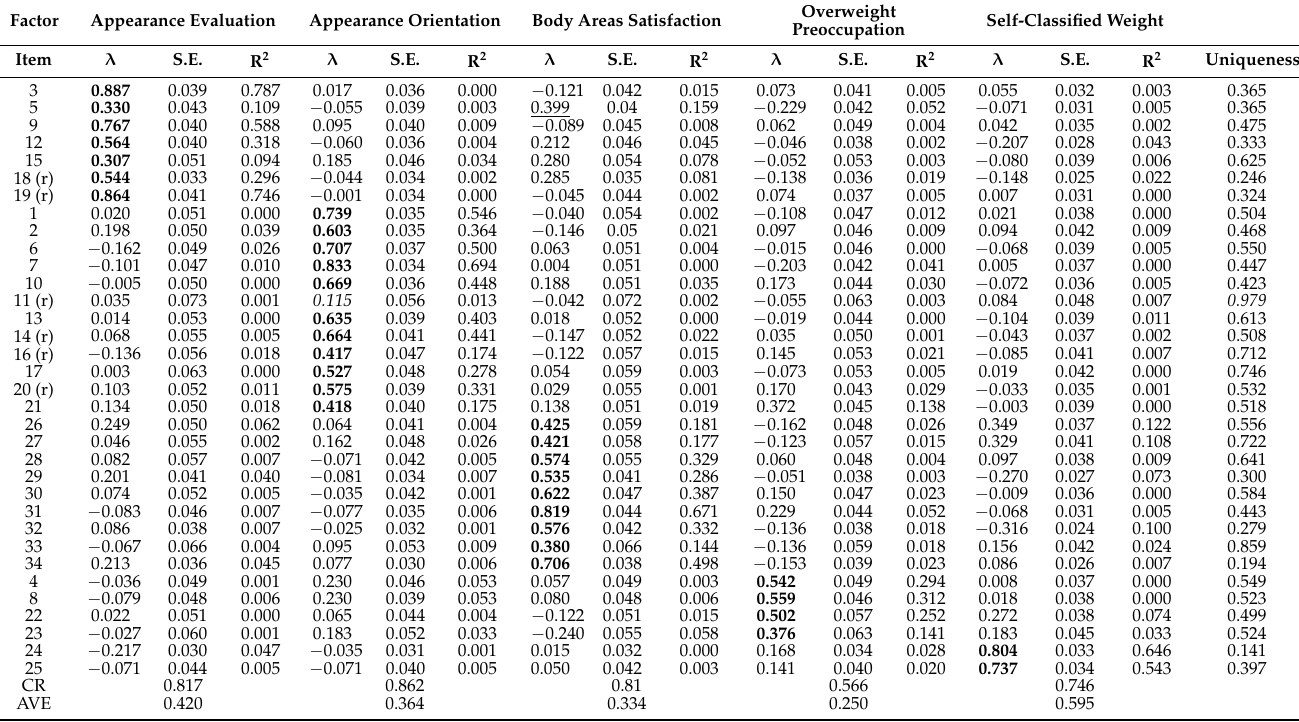
Table 4. Factor loadings for 5 factors ESEM target rotation.